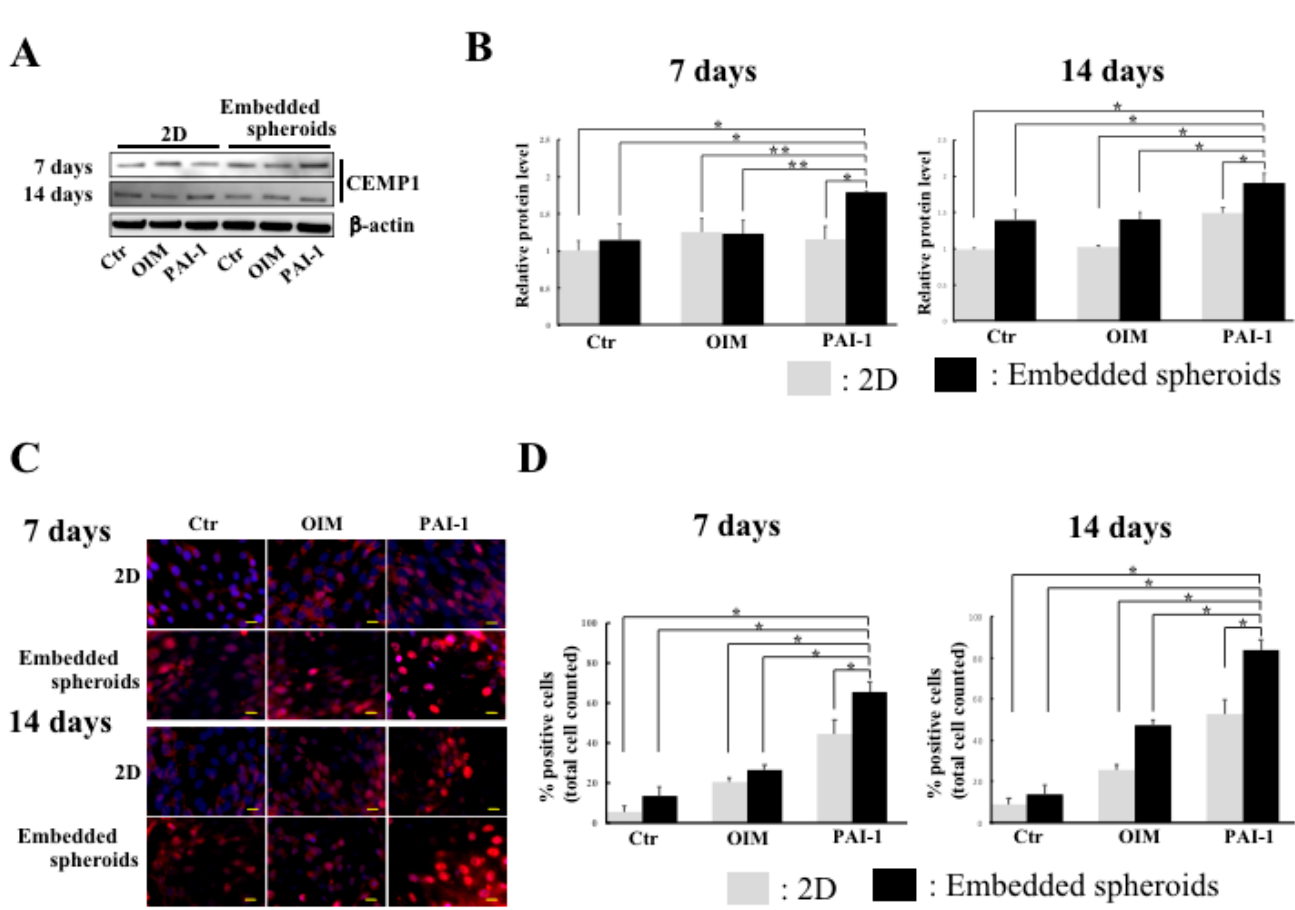
Figure 4. Increased CEMP1 expression in the rhPAI-1-treated embedded HPLSC spheroids. ( A ) West- ern blot of the CEMP1 expression in 2D-monolayered HPLSCs and the embedded HPLSC spheroids that were cultured in DMEM (control), OIM alone (OIM), and OIM containing rhPAI-1 (PAI-1; 100 ng/mL) for 7 and 14 days. ( B ) Quantification graphs of the protein expression were performed using the ImageQuant LAS4000 biomolecular imager. The relative levels of CEMP1 expression at 7 and 14 days were normalized with β -actin and expressed as fold-changes compared with 2D monolayered HPLSCs that were cultured with DMEM (control). Data represent the mean ± SD of three independent experiments. * p < 0.01, ** p < 0.05. ( C ) Fluorescence images of CEMP1 staining (red) in 2D-monolayered HPLSCs and the embedded HPLSC spheroids that were cultured in DMEM (control), OIM alone (OIM), and OIM containing rhPAI-1 (PAI-1; 100 ng/mL) up to 14 days. Nuclei were counterstained with DAPI (blue). The scale bar represents 20 µ m. ( D ) Semiquantification of the percentage of positive cells that were stained with CEMP1 at 7 and 14 days. Data represent the mean ± SD of three independent experiments. * p <